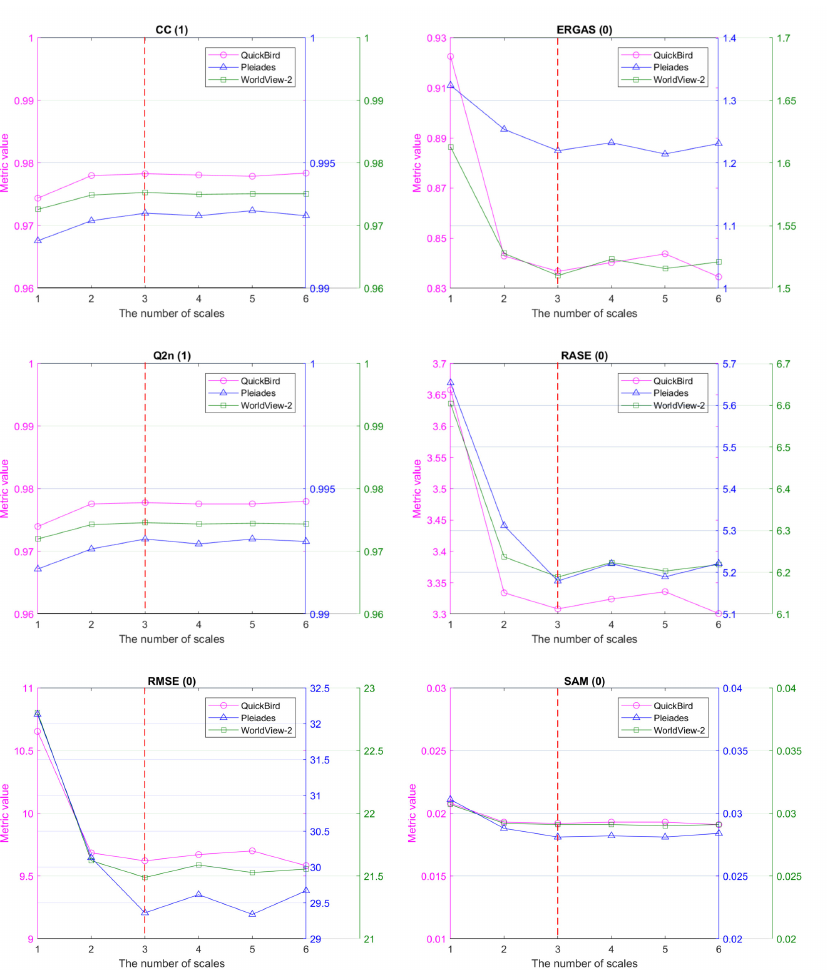
Figure 9. Quantitative fusion results by varying the number of scales on the three real remote sensing datasets.